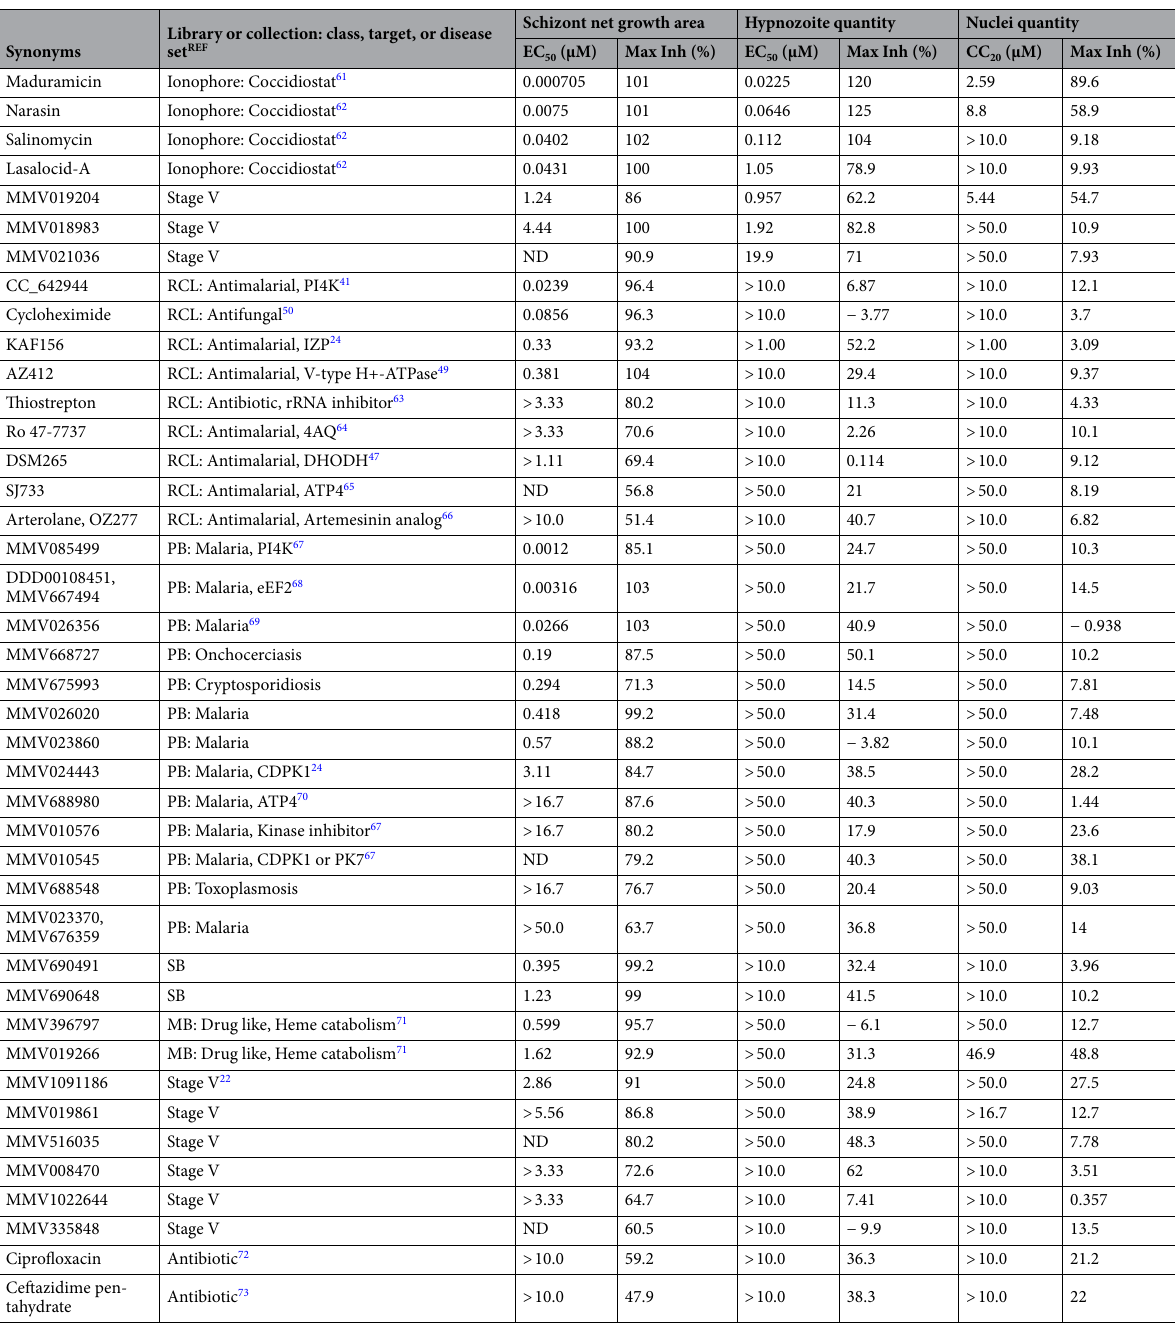
Table 2. Confirmed hits from 8-day radical cure assays. All EC 50 ’s, CC 20 ’s, and Maximum Inhibition (Max Inh) values are from the highest quality independent experiment. RCL, Reference Compound Library; PB, Pathogen Box; SB, Stasis Box; MB, Malaria Box; Stage V, P. falciparum stage V gametocyte active; eEF2, elongation factor 2; PI4K, phosphatidyl inositol 4-kinase; IZP, imidazolopiperazine; DHFR, dihydrofolate reductase; DHODH, dihydroorotate dehydrogenase; ATP4, ATPase 4; CDPK1, calcium-dependent protein kinase 1; PK7, protein kinase domain-containing protein 7; PKG, cyclic GMP-dependent protein kinase. Included are activity values for selective compounds; activity data for selective and nonselective compounds, as well as structures, can be found in Supplementary Table S2